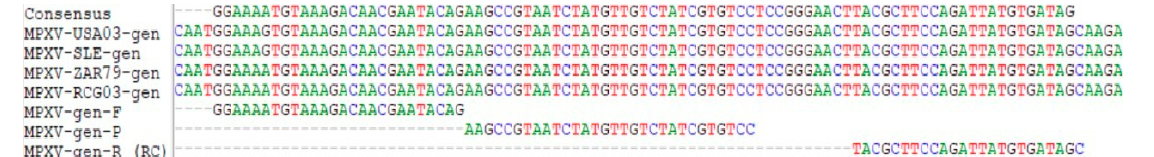
Figure 5. Previously published MPXV sequence. Alignment of the sequenced WA assay product (consensus) with reference sequences and PCR oligos. Alignment of the sequenced generic assay product (consensus) with reference sequences and PCR oligos.